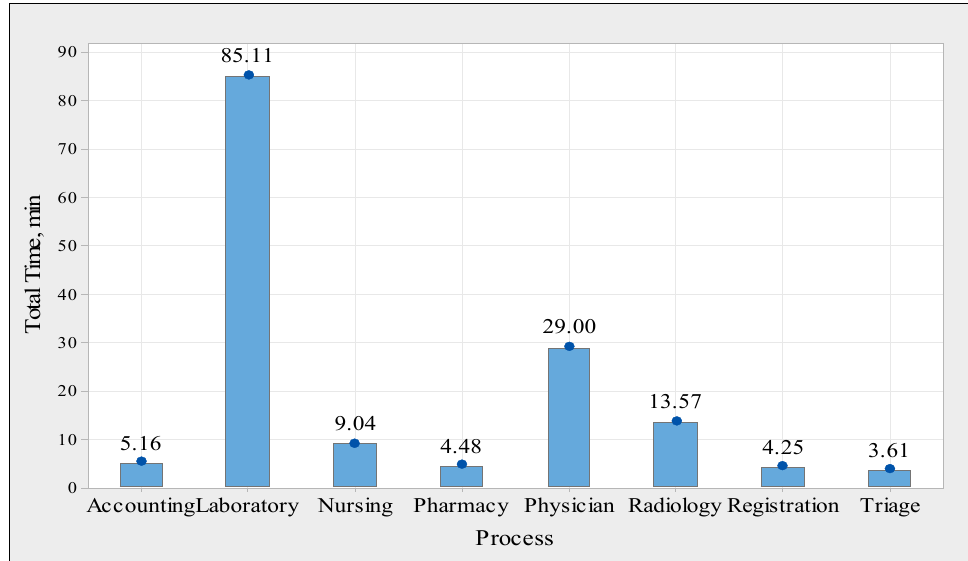
Figure 13. Bar chart of the average total time for the current state model .